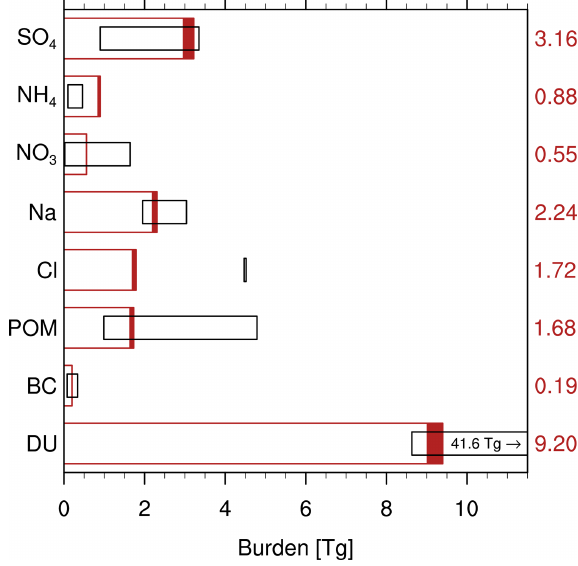
Figure 11. Global tropospheric aerosol burdens simulated by EMAC (MADE3). The filled part of each bar indicates the range of values for the 10 evaluated years. The average values are given on the right side of the plot. The ranges of values from a compilation of other studies (Lauer and Hendricks, 2006; Textor et al., 2006; Bauer et al., 2008; Wang et al., 2009; Mann et al., 2010; Pozzer et al., 2012; Kirkevåg et al., 2013; He and Zhang, 2014; van Noije et al., 2014; Lee et al., 2015; Michou et al., 2015) are shown as black boxes. Values for NH 4 have only been reported by Lauer and Hendricks (2006), Pozzer et al. (2012), and He and Zhang (2014); values for Cl only by He and Zhang (2014). The reported litera- ture range for Na is for sea spray. Note that this is not meant to be a comprehensive literature review but should yield a representative picture. Extreme values may stem from specific sensitivity